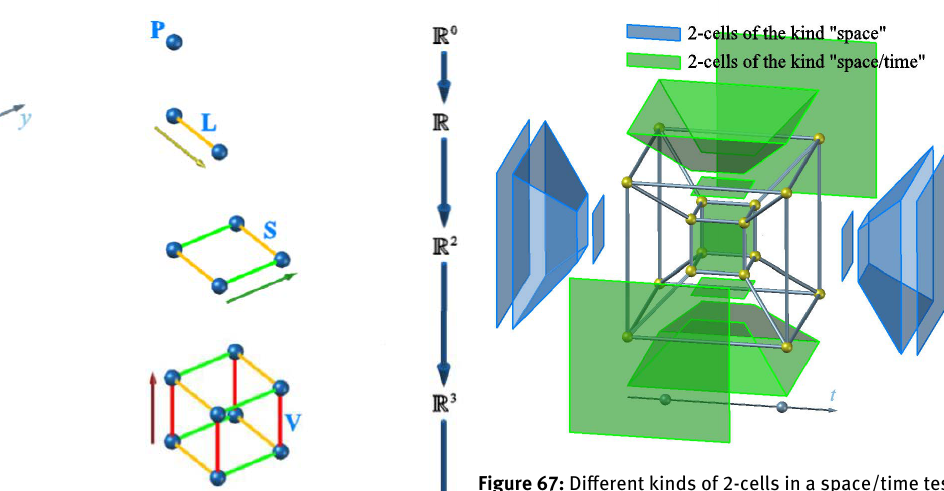
Figure 67: Different kinds of 2-cells in a space/time